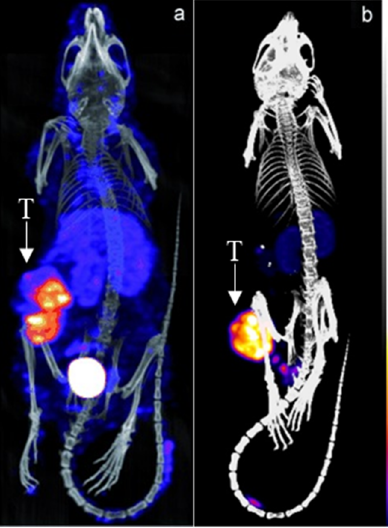
Figure 3. Pretargeted imaging of LS174T-tumor bearing mice using CC49-TCO and 111 In-DOTA- tetrazine ( a ) without and ( b ) with an albumin-based CA. T = tumor. Images from Refs. [53,54].